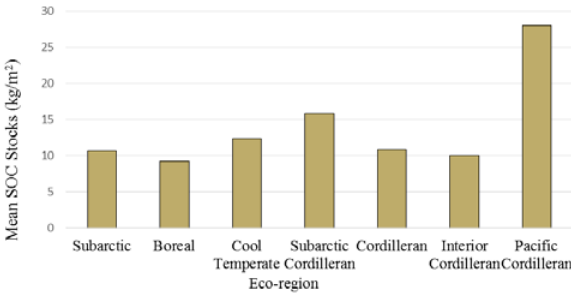
Figure 4. Mean SOC stocks (1961-1991) of each Canadian forest eco-region